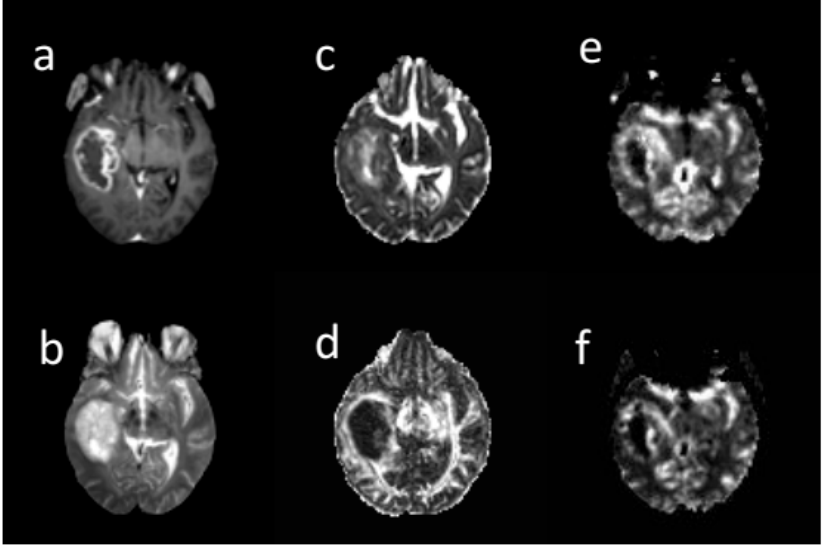
Figure 2. a sample of different brain MRI images: ( a ) post ‐ contrast T1 ‐ weighted, ( b ) T2 ‐ weighte, ( c ) Figure 2. A sample of different brain MRI images: ( a ) post-contrast T1-weighted, ( b ) T2-weighte, MD map, ( d ) FA map, ( e ) CBV map, ( f ) CBF map in 66 ‐ years ‐ old woman with glioblastoma. All ( c ) MD map, ( d ) FA map, ( e ) CBV map, ( f ) CBF map in 66-years-old woman with glioblastoma. images are co ‐ registered to the B0 DTI images. The tumor region was segmented into contrast All images are co-registered to the B0 DTI images. The tumor region was segmented into contrast enhanced, non ‐ enhanced, necrosis in post ‐ contrast image, low and high diffusion in MD map, and enhanced, non-enhanced, necrosis in post-contrast image, low and high diffusion in MD map, low and high perfusion in rCBV map by k ‐ means. Based on their overlapping, sub ‐ regions were and low and high perfusion in rCBV map by k-means. Based on their overlapping, sub-regions obtained. were